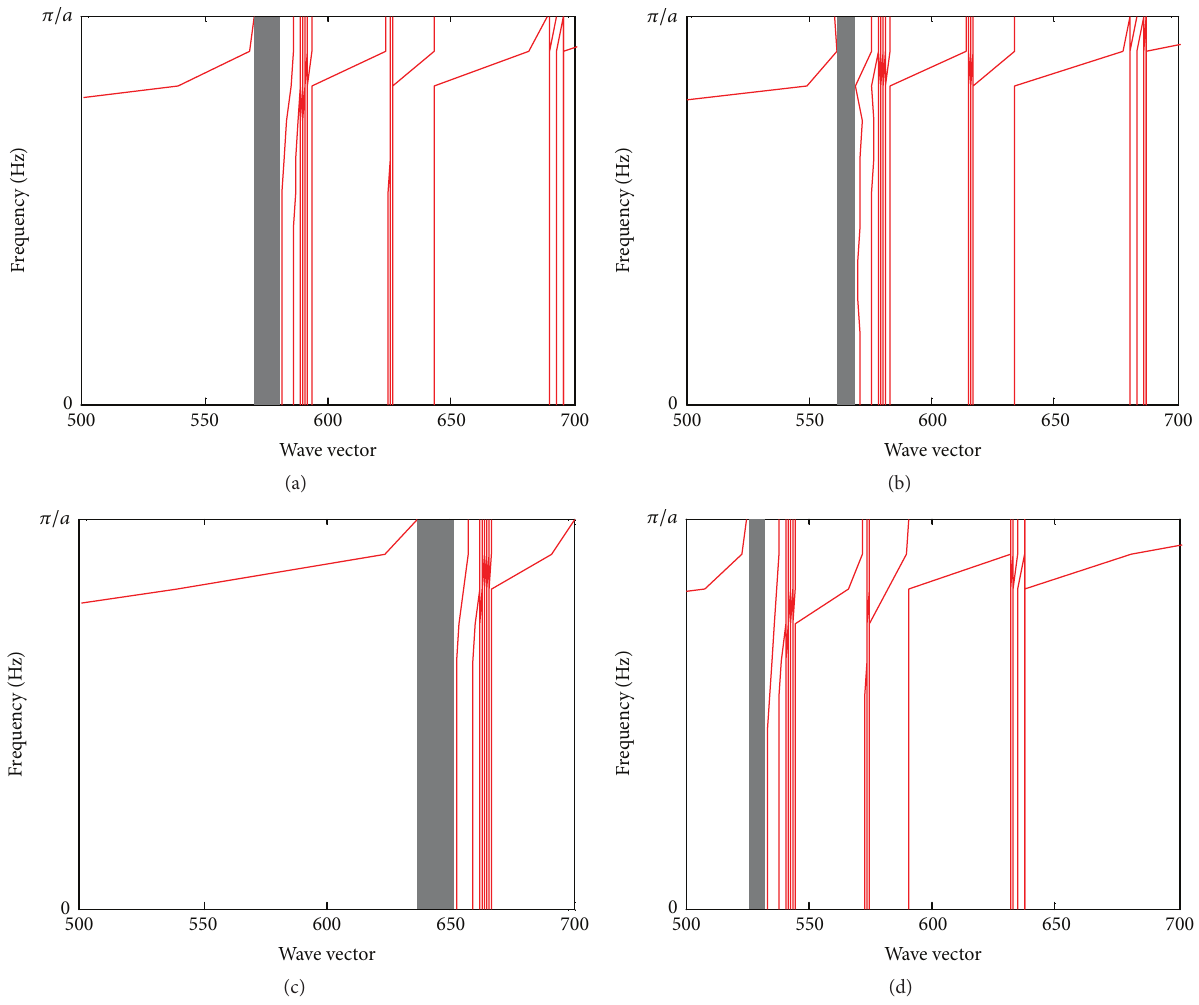
Figure 6: LR band gaps of the two-dimensional PPC-C with different circuit parameters: (a) 𝑅 𝐿 = 200 Ω , 𝐿 = 0.25 H; (b) 𝑅 𝐿 = 400 Ω , = 50 Ω , 𝐿 = 0.20 H; (d) 𝑅 = 50Ω , 𝐿 = 0.30 H. 𝐿 = 0.25 H; (c) 𝑅 𝐿 𝐿